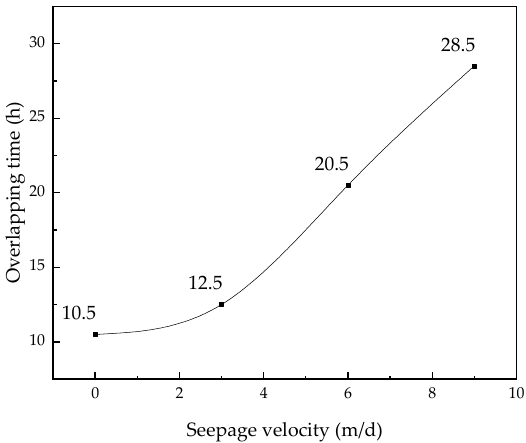
Figure 12. The relationship between the velocities and the overlapping times.